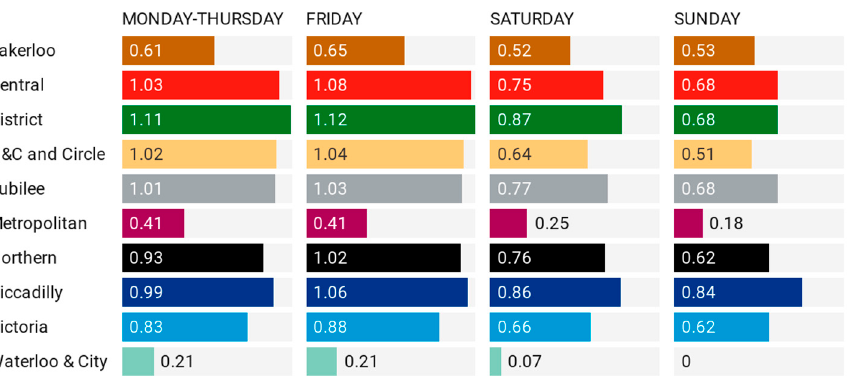
Figure 12. LU occupancy rate by line.